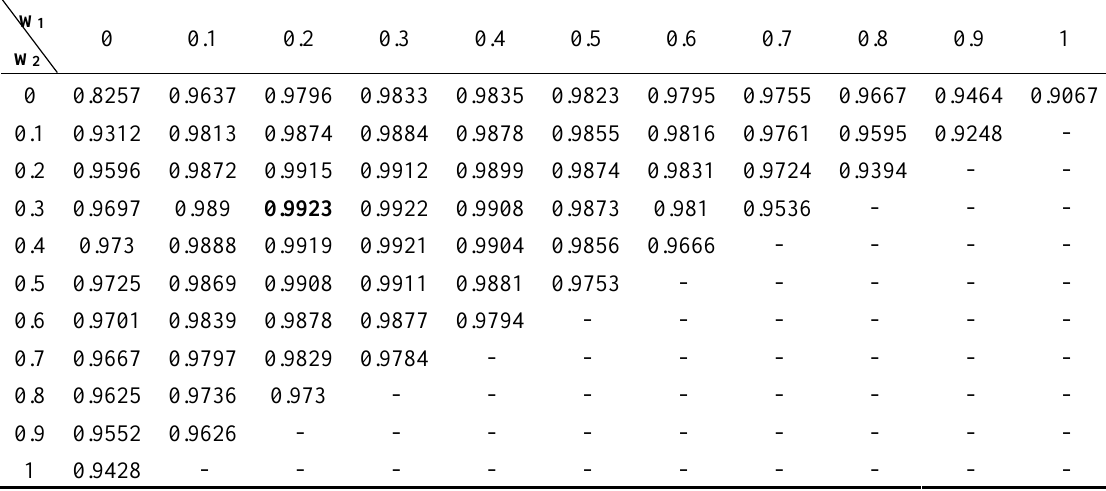
w for RF-NRS in w and 2 1